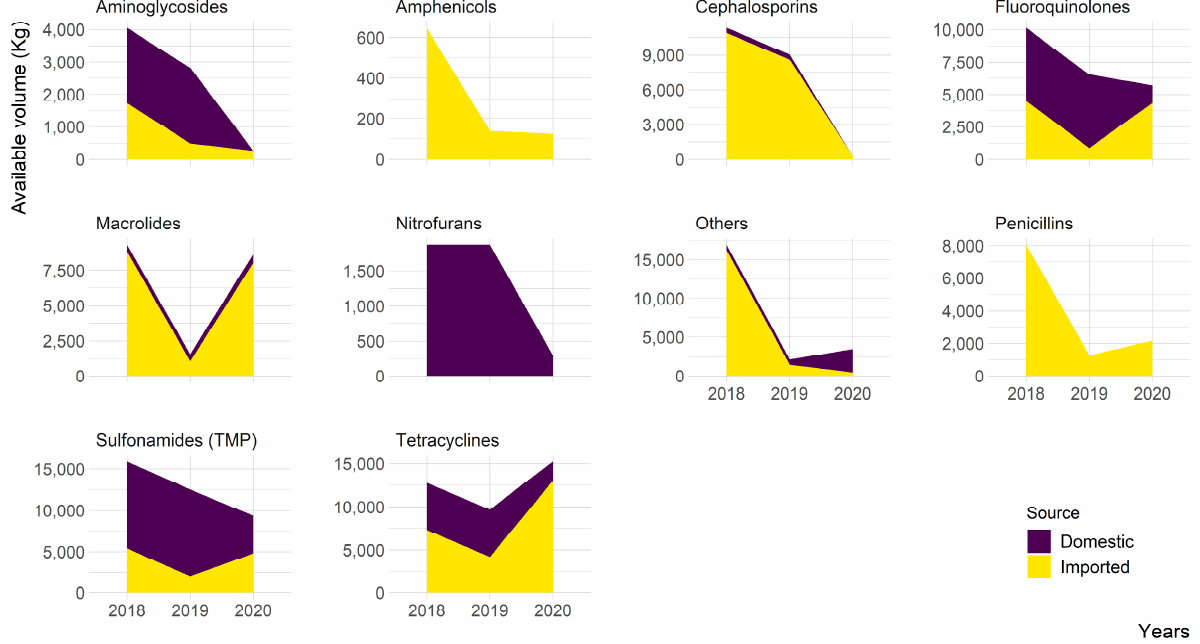
Figure 3. The volume of imported and domestic antimicrobials available in Nepal for veterinary medical use between 2018 and 2020 (Others include tylosin, tiamulin, bacitracin, and tilmicocin).